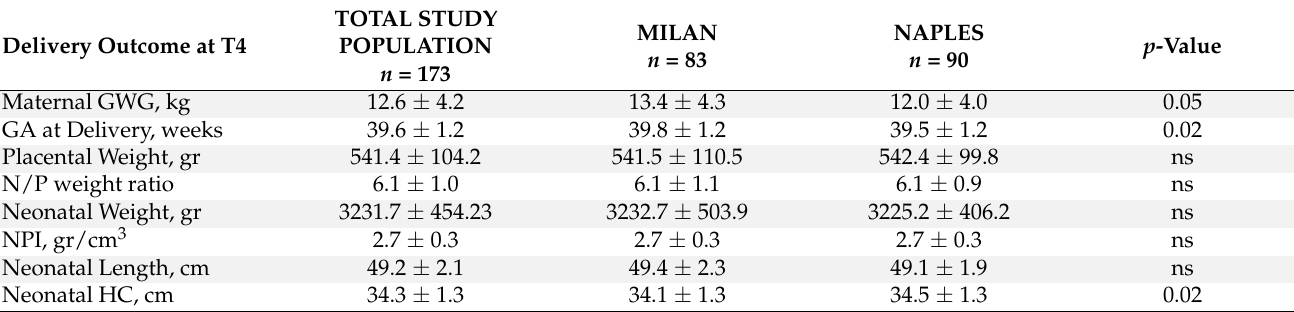
Table 2 lists pregnancy outcome at T4. Table 2. Delivery outcomes in the total study population and